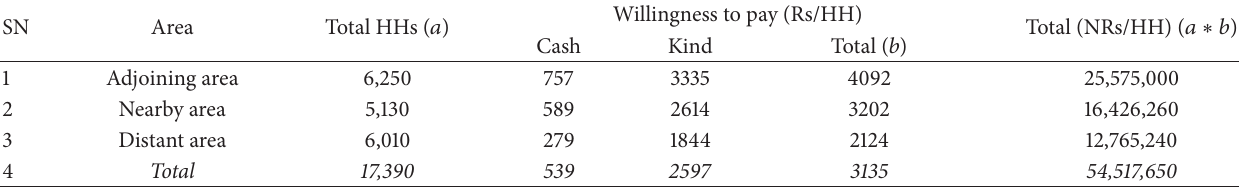
Table 11: Future use value of the